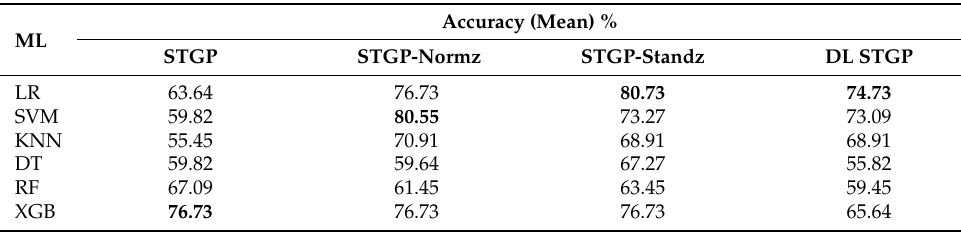
Table 8. KOA vs. HC Accuracy of ML models.